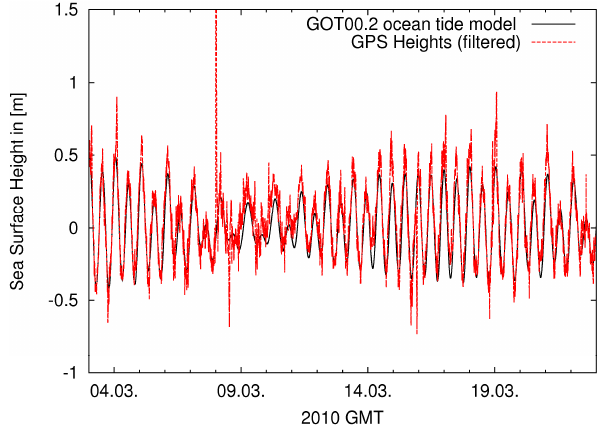
Figure 5: Comparison of GPS data and the ocean tide model GOT00.2 (Ray, 1999) for a 2 Fig. 5. Comparison of GPS data and the ocean tide model GOT00.2 GITEWS off-shore buoy. Shown in green is the model; the GPS time series is shown in red. 3 (Ray, 1999) for a GITEWS off-shore buoy. The model is shown in Differences in phase and amplitude are due to the model. Spikes in the GPS curve are 4 green; the GPS time series is shown in red. Differences in phase commonly through undetected cycle slips in the reference base station. 5 and amplitude are due to the model. Spikes in the GPS curve occur commonly through undetected cycle slips in the reference base station.